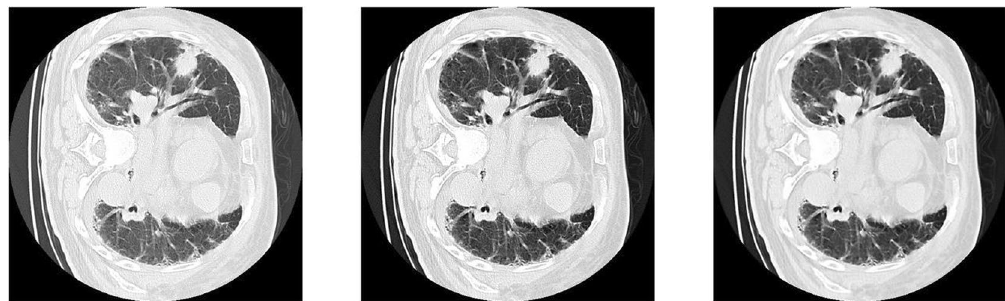
Figure 3. From left to right, Original CT image, With CLAHE, With CLAHE and Wiener.